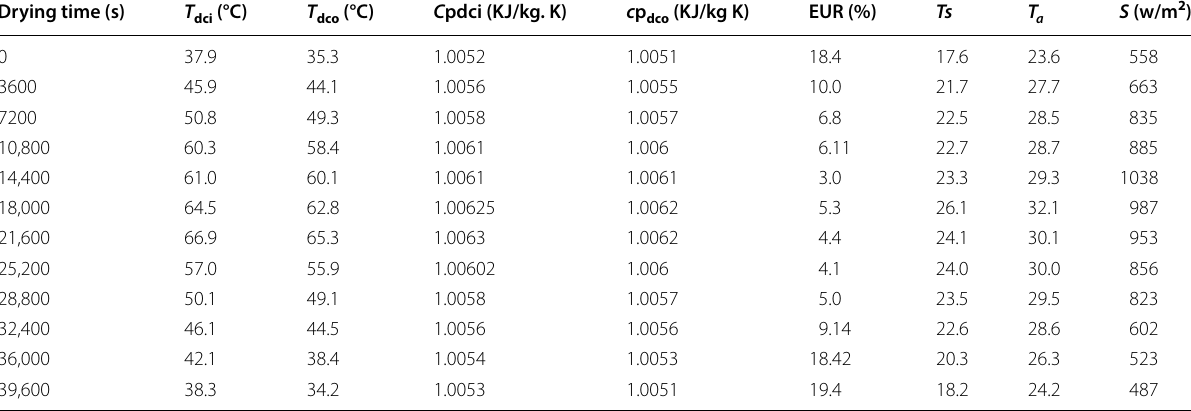
Table 16 Result energy analysis potato 1st day